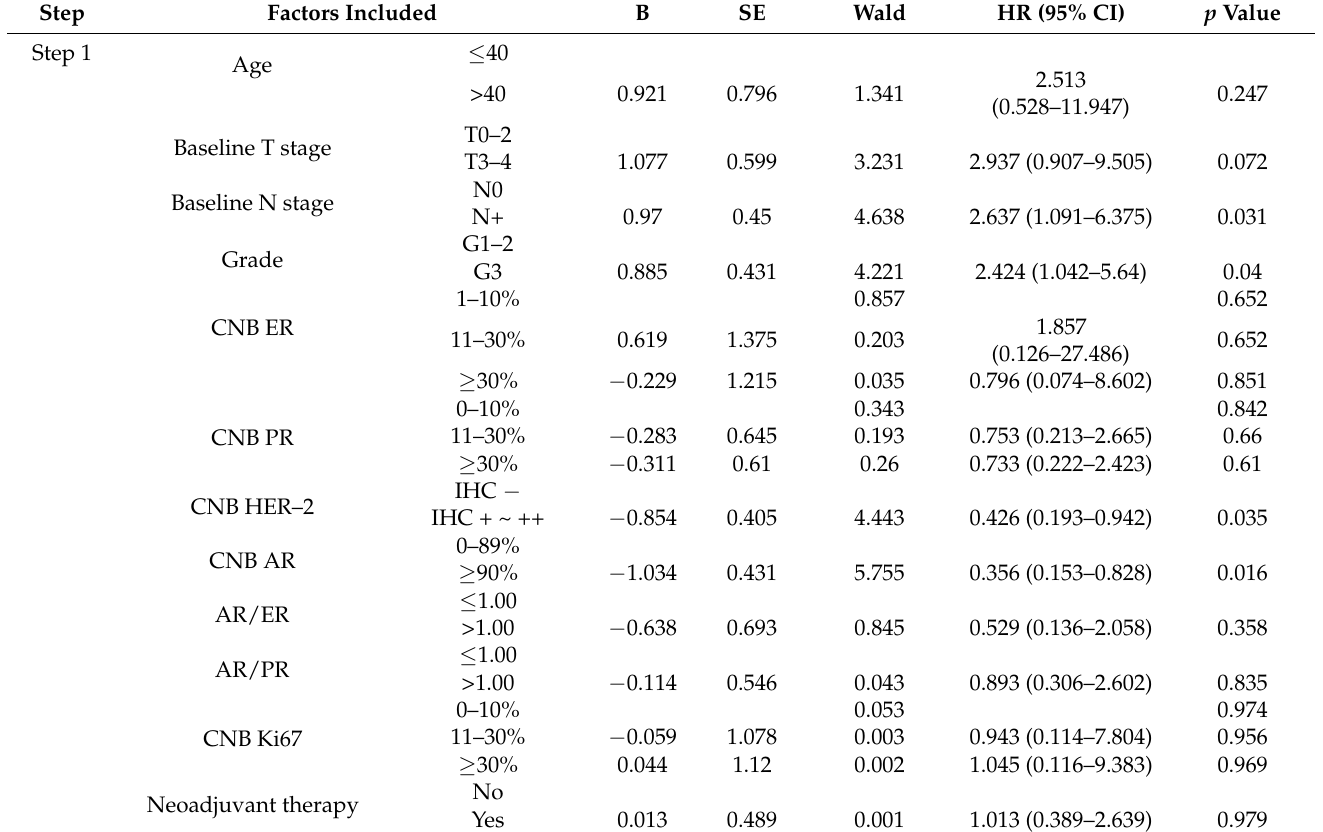
Table 4. Multivariate analysis of OS in the luminal B (HER–2 negative) BC study